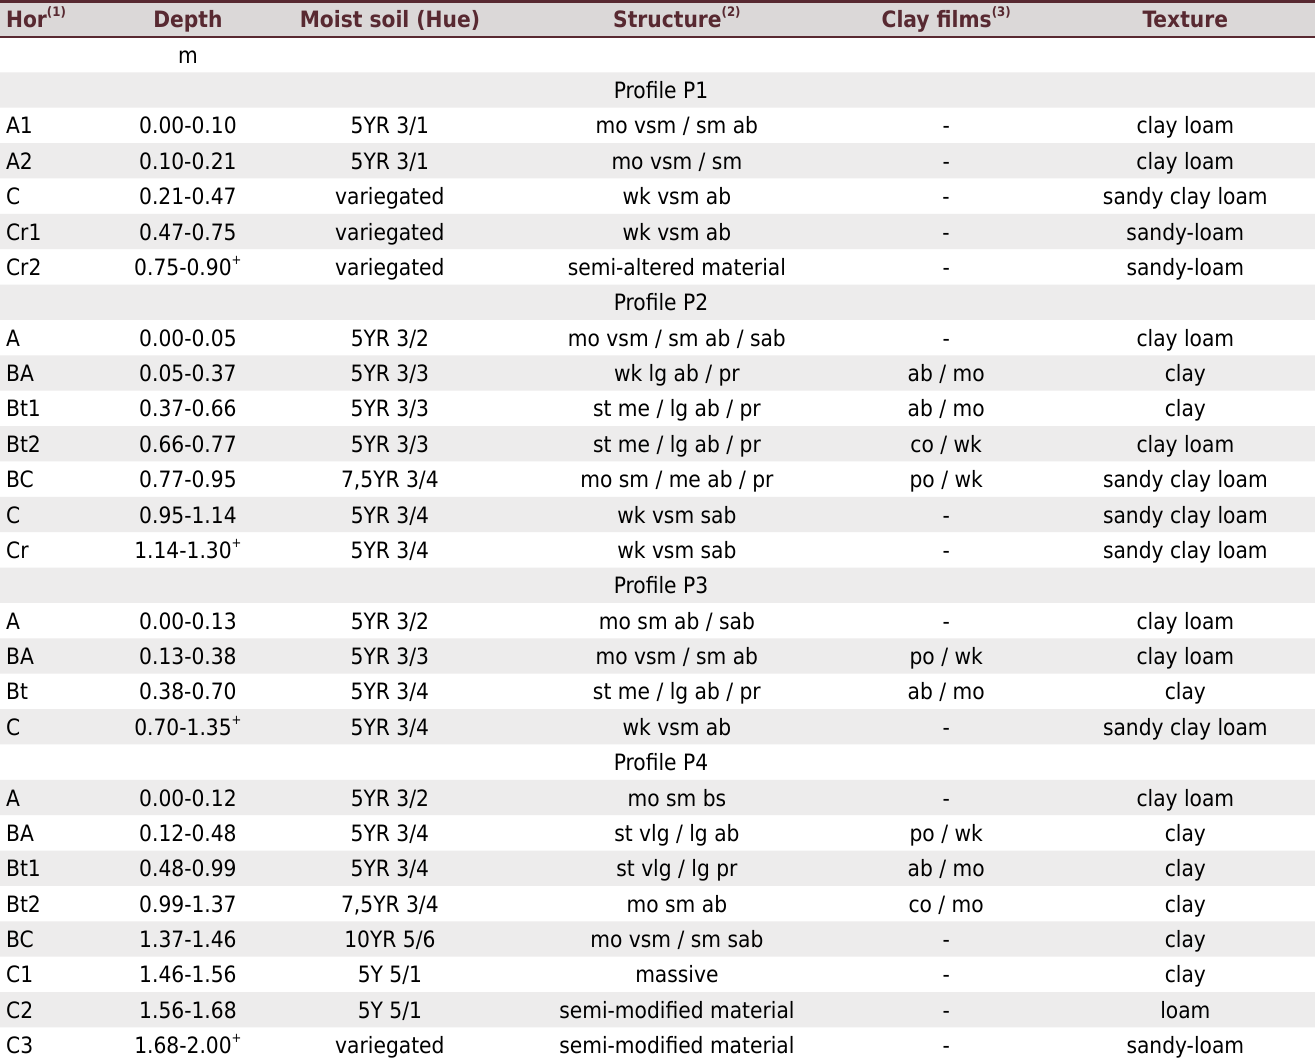
Table 1. Morphological attributes of soils in a toposequence in Pinheiral,